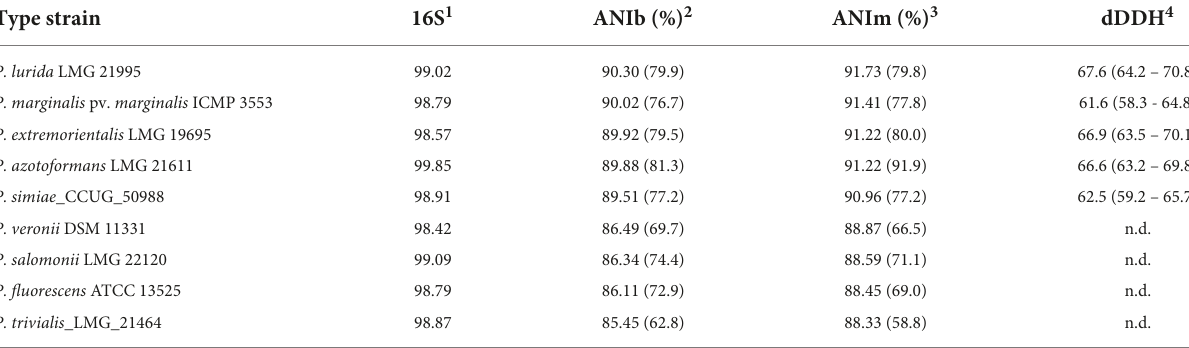
TABLE 4 Overall genome relatedness indices derived from pairwise genomic comparison between Pseudomonas sp. strain 1008 and type species with the highest similarity of 16S rDNA